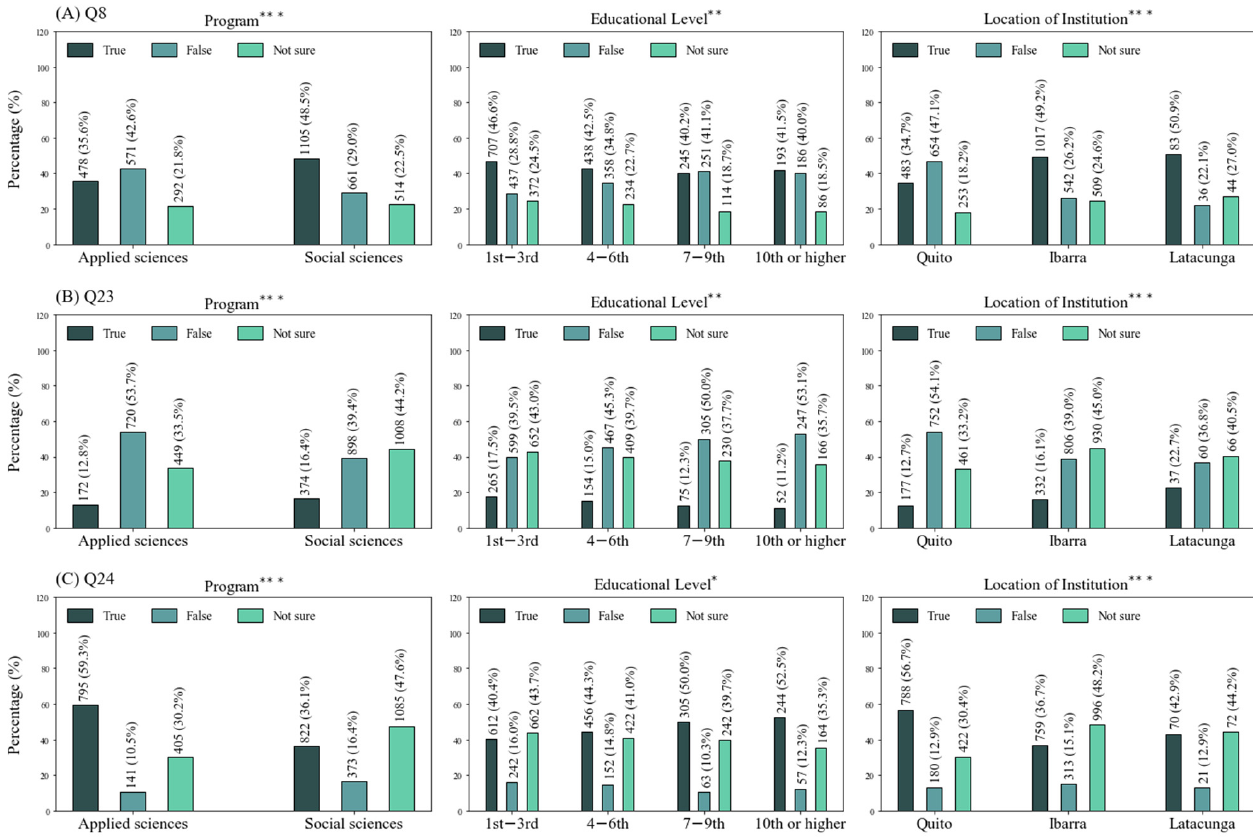
Figure 1. Percentages of questions answered correctly by less than half of the population. ( A ) Question 8; ( B ) Question 23; ( C ) Question 24. * Chi-square values significant at p < 0.05; ** at p < 0.01; *** at p < 0.001.